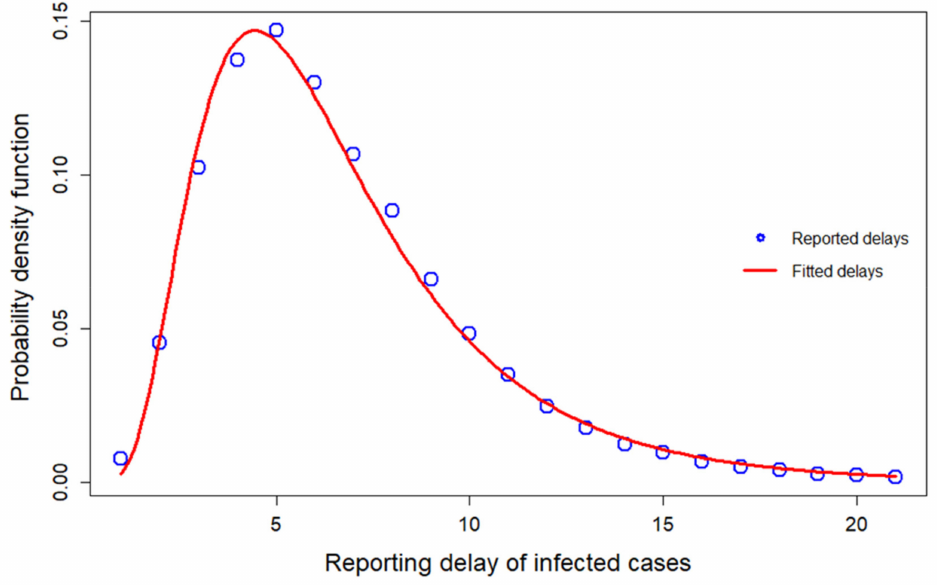
Figure A1. Approximation of reporting delay by a log-normal distribution: We present the log- normal distribution best fitting the empirical distribution of reporting delays. Estimated parameters of the log-normal distribution are as follows: µ = 1.77 days, σ = 0.531